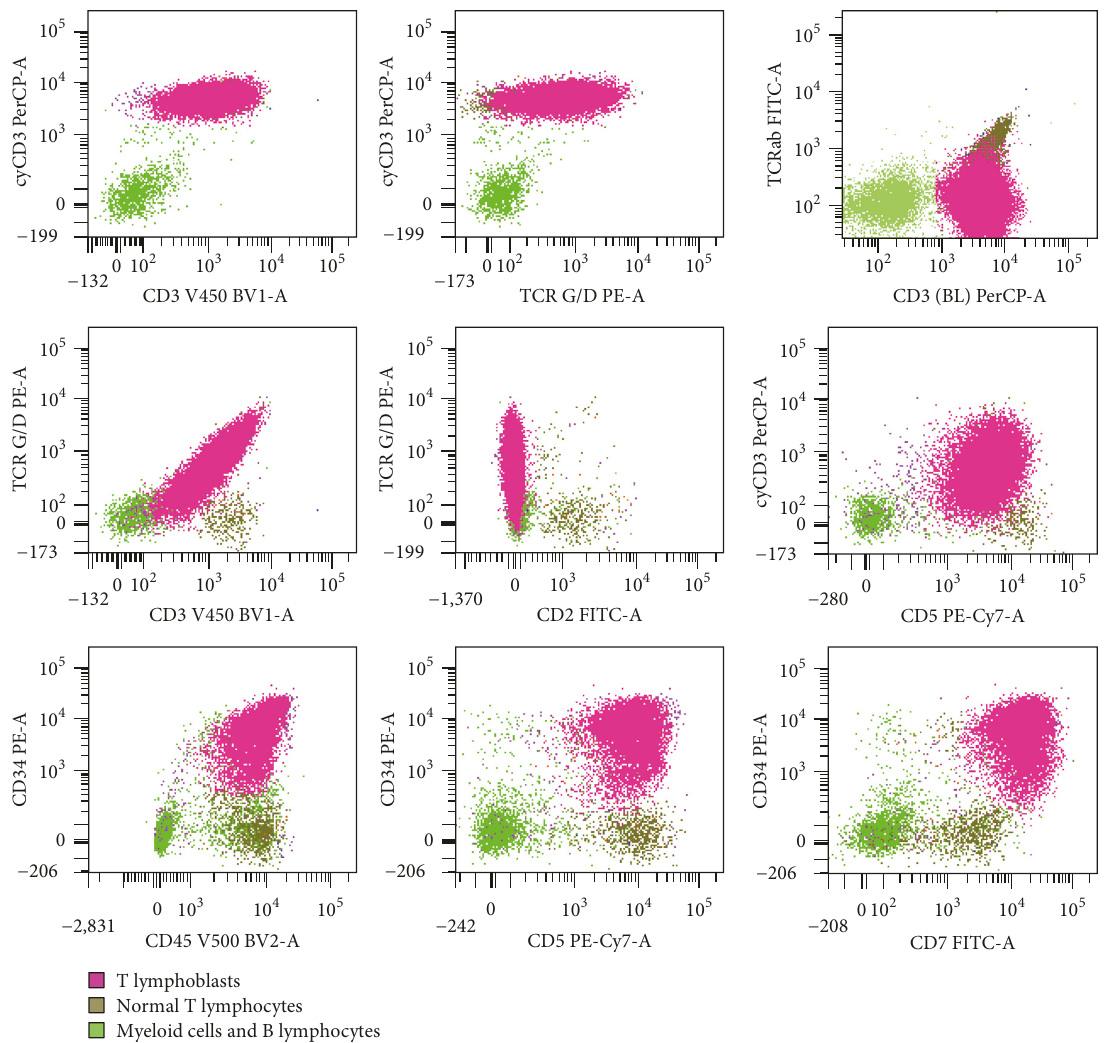
Figure 2: Representative flow cytometric histograms of bone marrow aspirate from patient